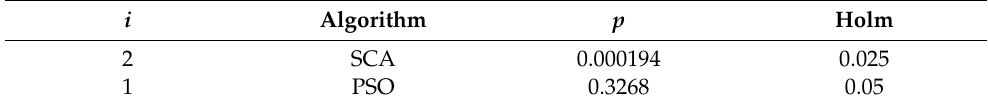
Table 5. Holm Post Hoc for Number of